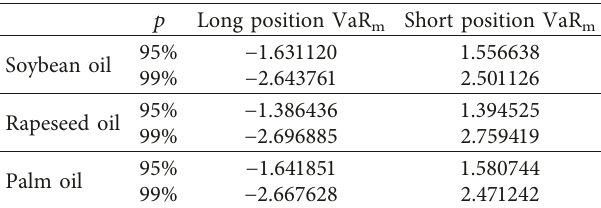
Figure 12: Palm oil-Hill plots and the MEF plots. Table 7: Thresholds u 1 selection.